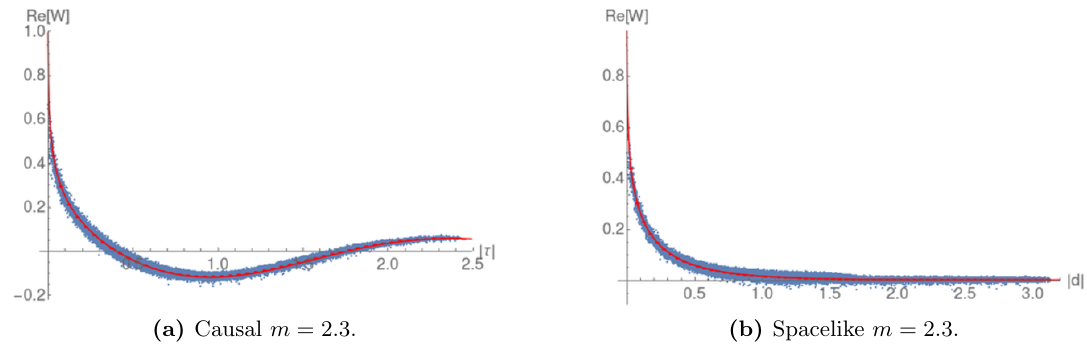
Figure 12. N = 24000 ; T = 1 ; (cid:26) = 1226 : 31, in 2d de Sitter. The scatter plot is Re[ W geodesic distance for a sample of 100000 randomly selected pairs. The red curve represents the continuum W E from